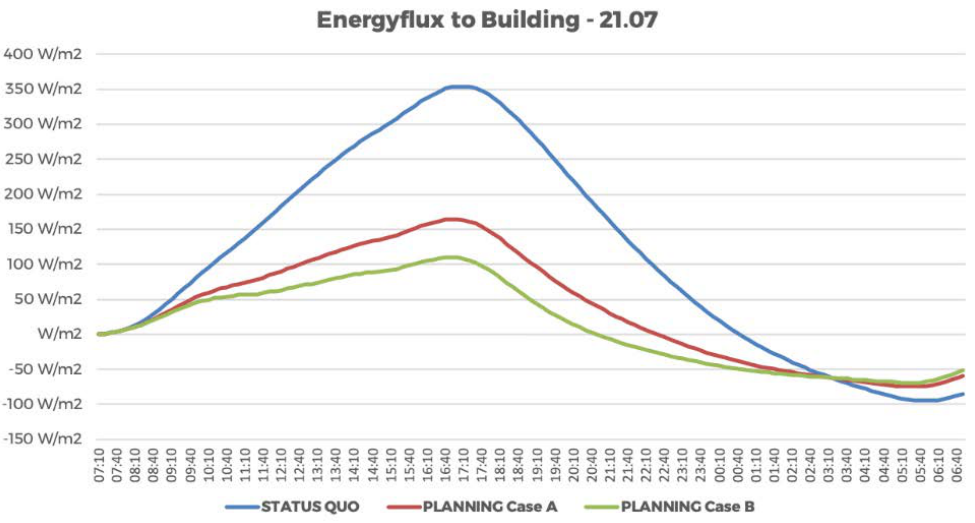
Figure 12. KPI energy flux of building (EFB) day profile for Elief Playhouse Antwerp scenarios on an idealized typical hot summer day (21.07).